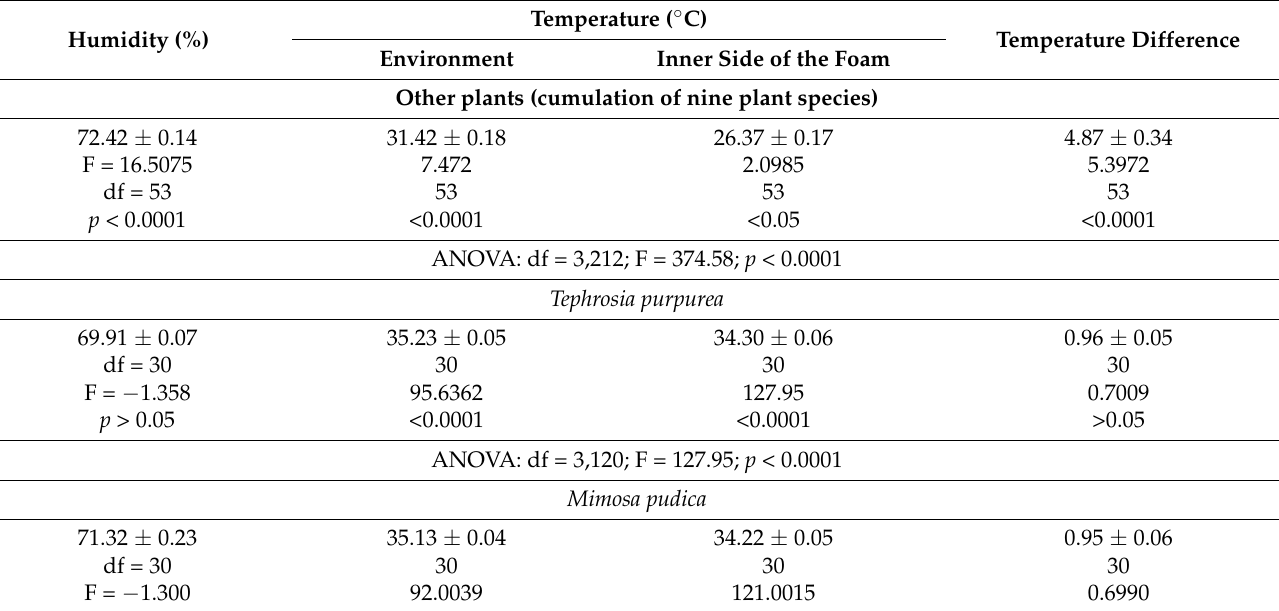
Table 3. Foam inner temperature ( ◦ C) in relation to environmental humidity (%) and temperatures ( ◦ C).